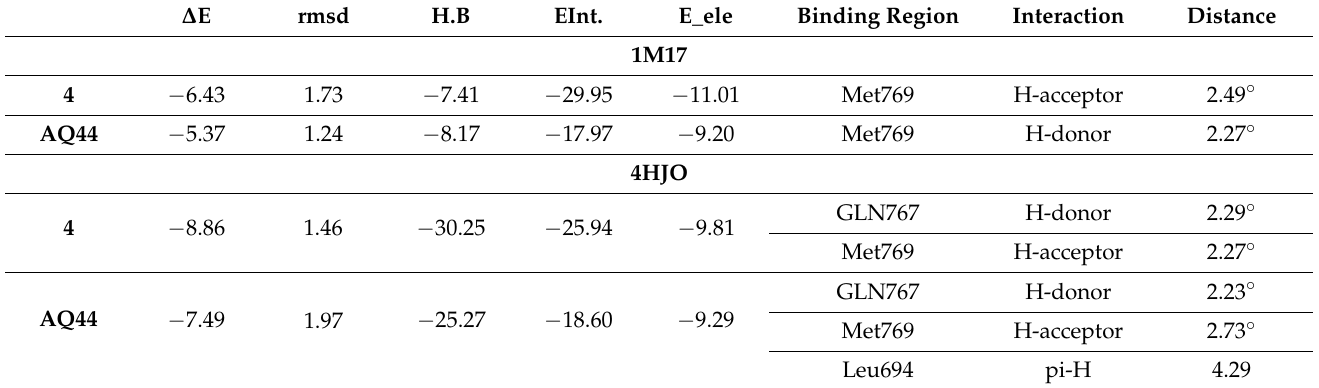
Table 5. Docking score in (kcal/mol) for compound 4 against